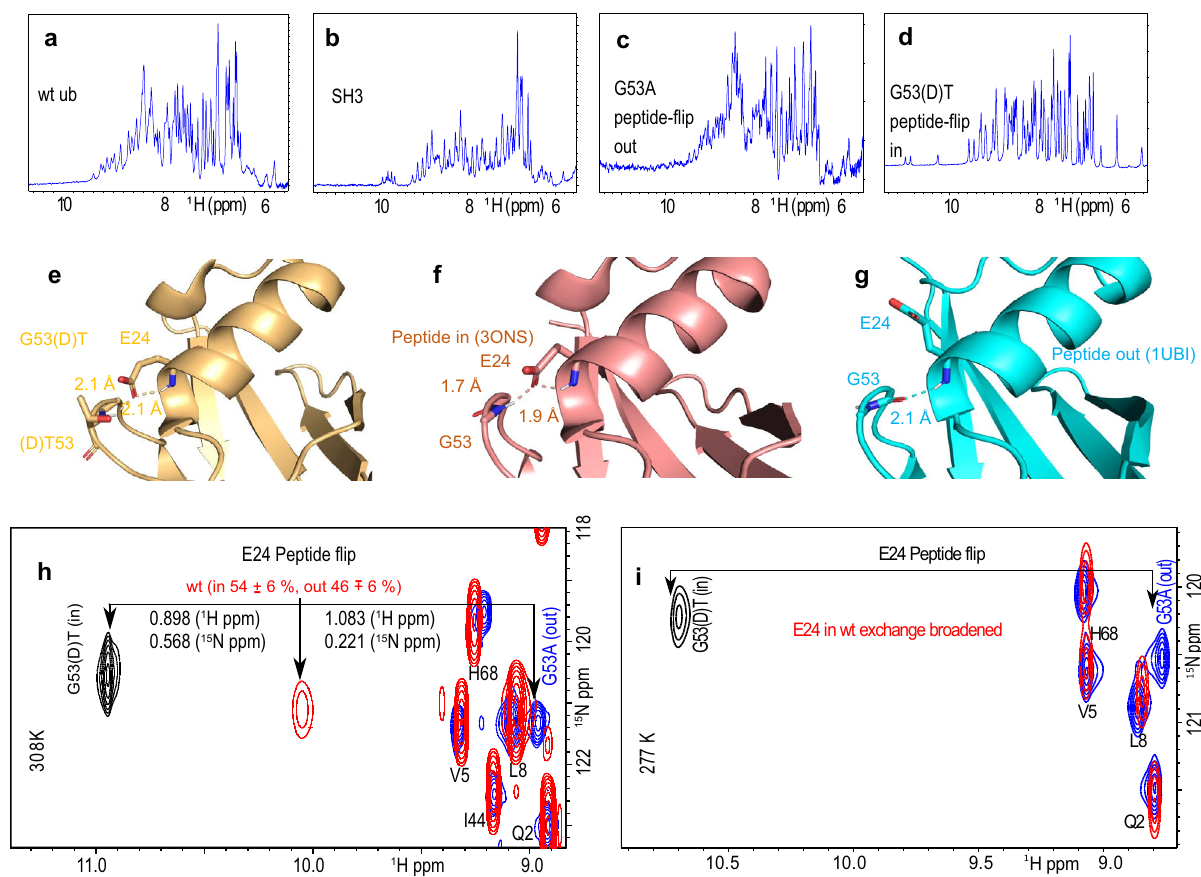
Fig. 5 NMR spectroscopy characterization of SH3c and ubiquitin wt and mutants G53(D)T and G53A. a – d 1H NMR spectra of the amide region showing for all proteins a range of chemical shifts up to or more than 9 ppm, indicating that the two mutants of ubiquitin as well as the wt and the construct of SH3c are well-folded in the buffer condition used for the experiments. e – g crystal structures of the G53(D)T mutant as well as the two crystal structures of wt ubiquitin showing the “ in ” conformation of the peptide bond ( f ) and the “ out ” conformation ( g ). The G53(D)T ( e ) mutant of ubiquitin (golden ribbon) has a similar poise of the G53 peptide-bond and the side-chain of E24 as the wild-type ubiquitin in the “ in ” conformation ( f , magenta ribbon, PDB: 3ONS). The side-chain of the (D)T53 is shown in stick representation. The dihedral angles for (D)T53 ( ϕ : 109.7°; ψ : 18.6°) show that the molecules is locked into the peptide- fl ip “ in ” conformation. For comparison, the dihedral angles of G53 in the “ in ” conformation are ϕ : 98.6°, and ψ : − 25.6° (PDB: 3ONS) and “ out ” conformation along the peptide- fl ip mode, are ϕ : − 82.9°, and ψ : − 8.9° (PDB: 1UBI). HSQC spectra of the wt, the G53(D)T and G53A mutant of ubiquitin at 308K ( h ) and 277 K ( i ). The black arrows indicate the positions of the NH resonance of E24. The G53(D)T and G53A mutants were designed to redistribute the populations to “ in ” and “ out ” conformations along the peptide- fl ip mode, according to the increase of the effective molecular weight. No line broadening due to intermediate exchange is seen.